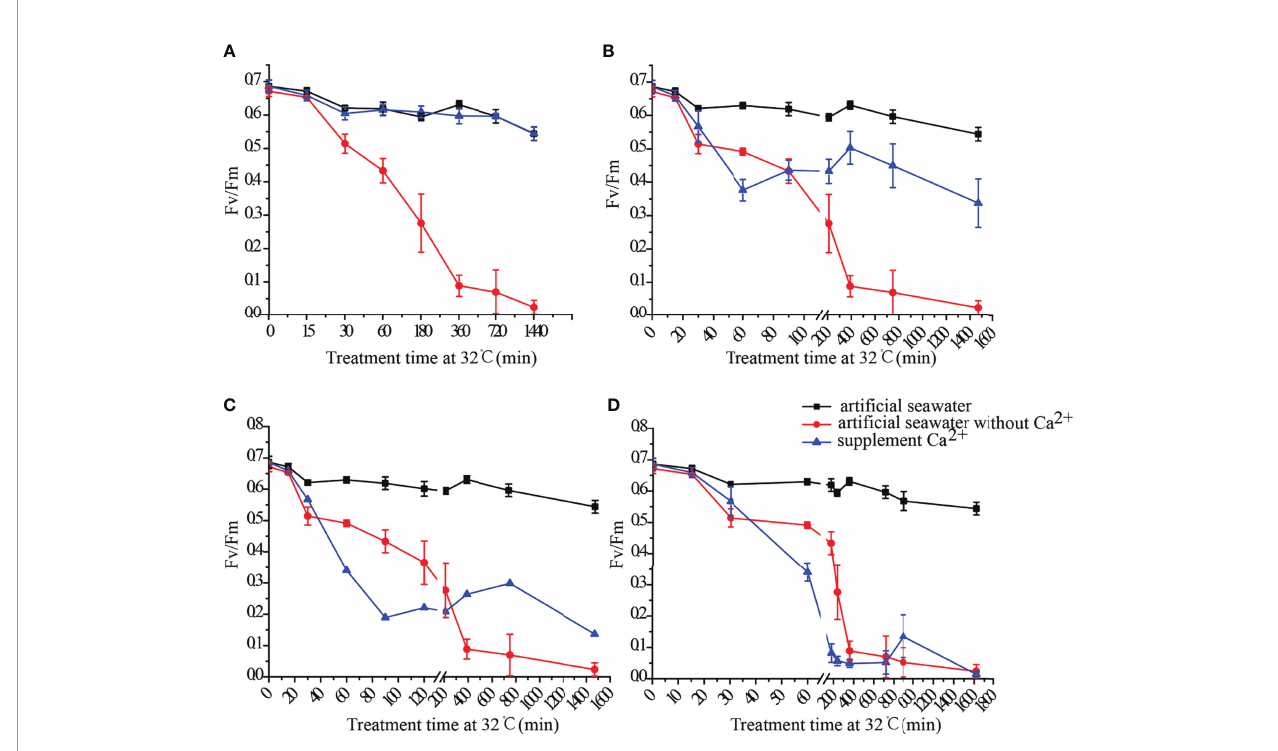
FIGURE 1 | Fv/Fm of N. haitanensis thalli after adding Ca 2+ at 15 min (A) , 30 min (B) , 1 h (C) and 3 h (D) of heat